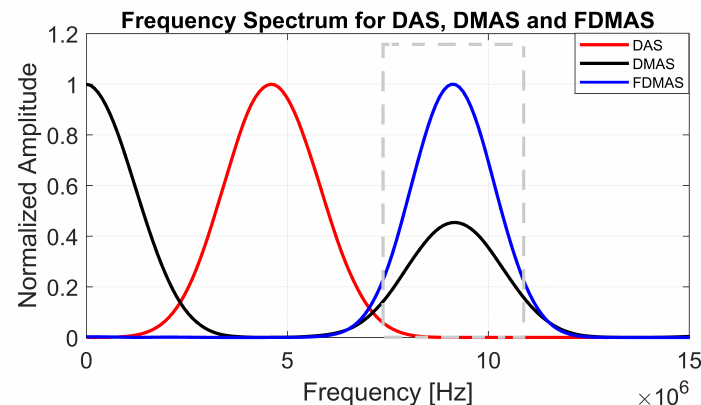
Figure 6. Normalized frequency spectra obtained with DAS, FDMAS and FMAS. The frequency spectrum was performed on a single point target located at a 30 mm depth as shown in Figure 3. The dashed grey box represents a BPF between 8.5 and 11.5 MHz to extract the second-harmonic component for